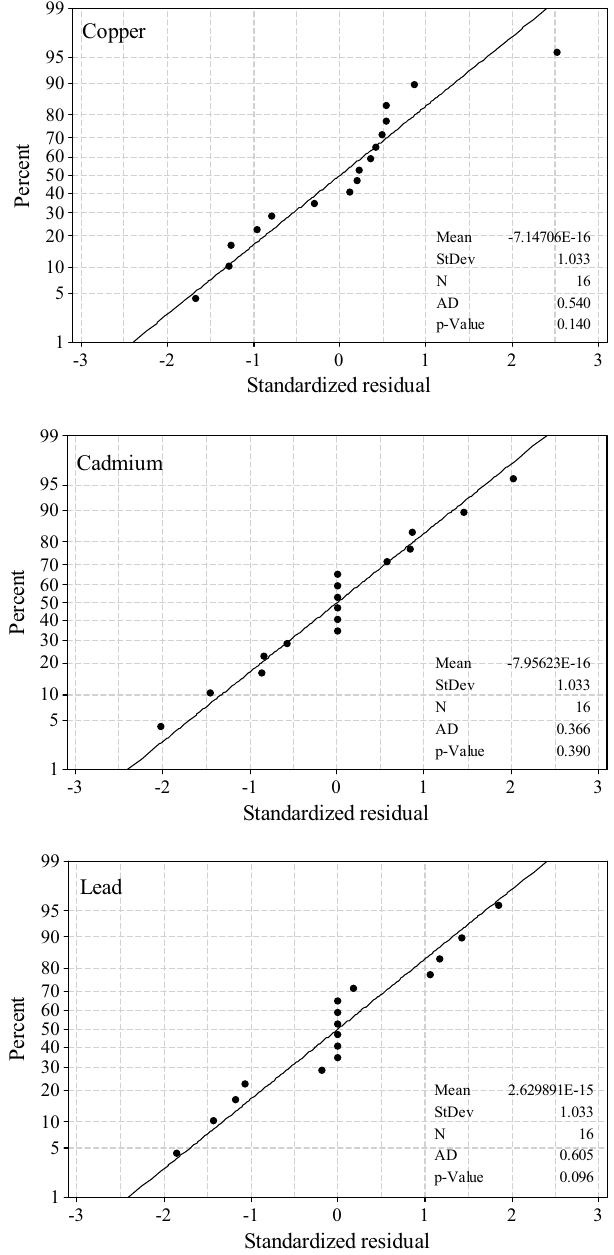
Figure 3. Normal probability plots of residual values for removal efficiency of Cu 2+ , Pb 2+ and Cd 2+